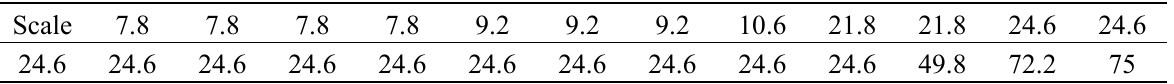
Table 8. Scale parameter values obtained (sorted) from the results depicted in Table 6 with MS segmentation, no transformation and the Reference Weighted Jaccard (RWJ)